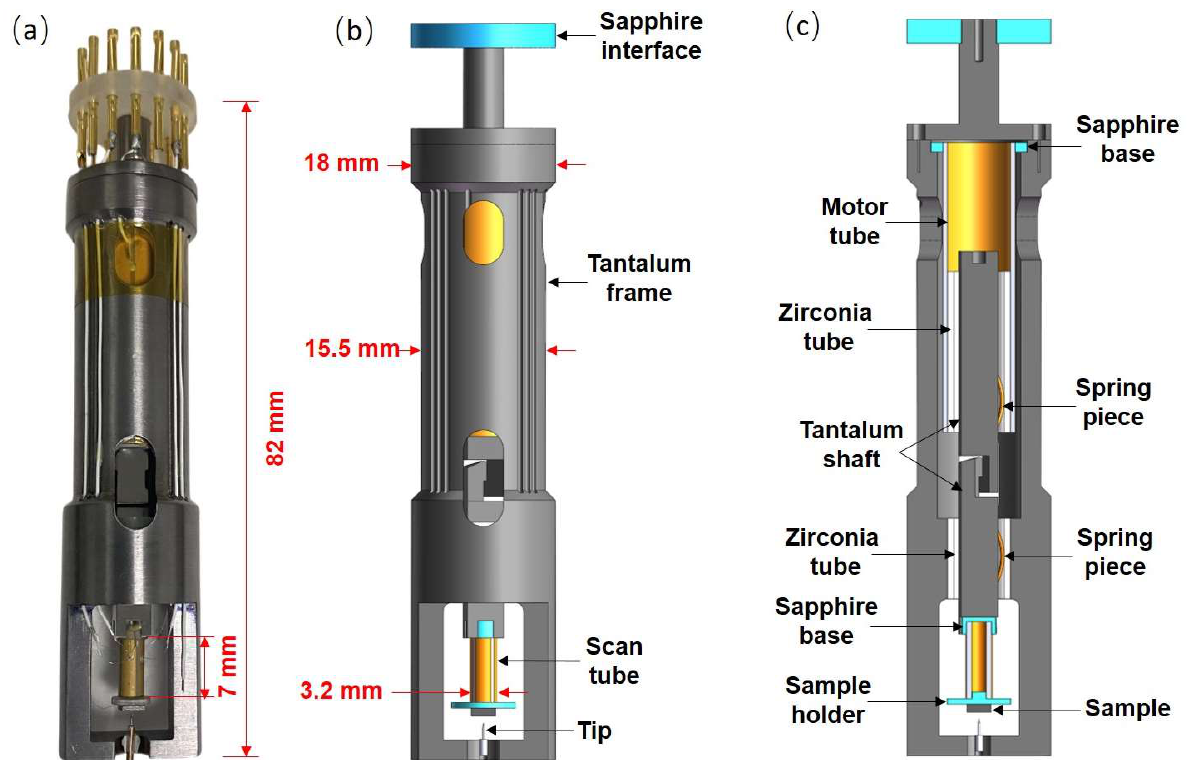
Figure 1. ( a ) Photograph of the STM head. ( b ) Three-dimensional schematic diagram of the STM. ( c ) Section view of the STM head. Detailed parts are displayed in ( b ) and ( c ).